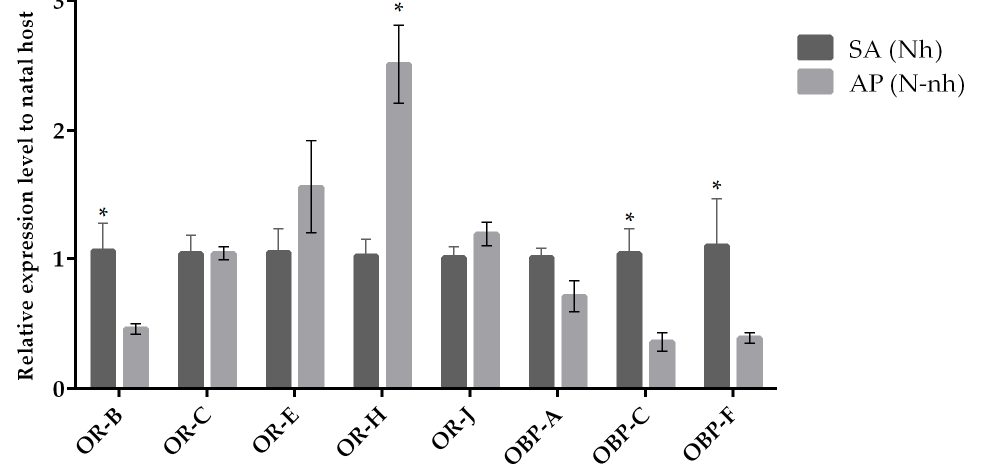
Figure 2. Mean (+/ − SE) expression levels of ORs and OBPs from the heads of A. ervi maintained on the natal host SA ( S. avenae ; Nh) or on the non-natal host AP ( A. pisum ; N-nh) measured by RT-qPCR. RT-qPCRs were performed using specific primers for each gene. Normalizer gene: RPL19. The asterisk * above the bars indicates significant differences according to two-way ANOVA ( p value < 0.05).